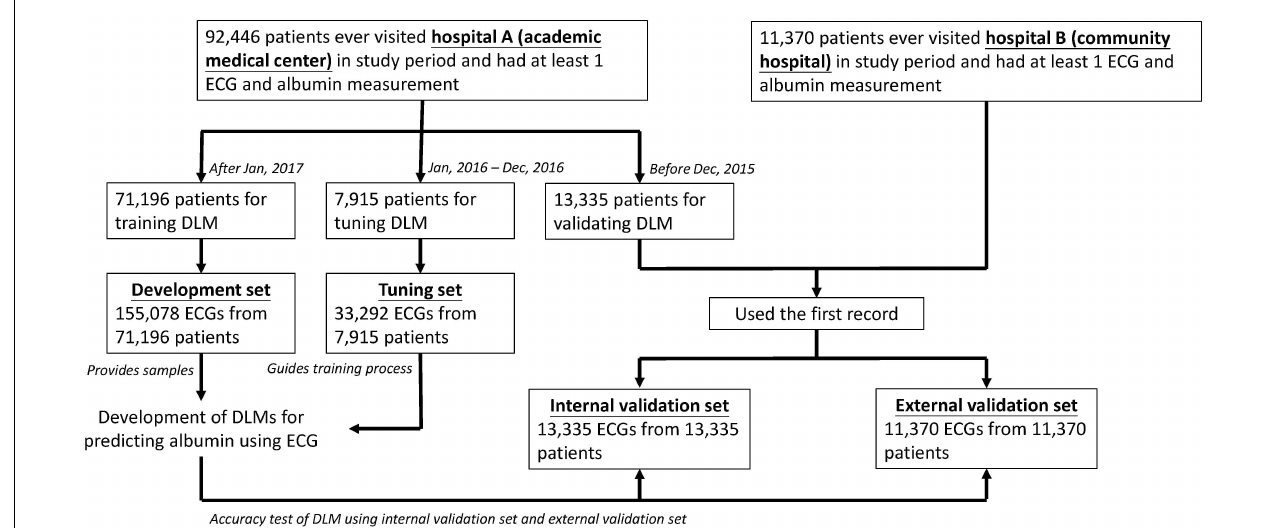
FIGURE 1 | Development, tuning, internal validation, and external validation set generation and ECG labeling of albumin. Schematic of the dataset creation and analysis strategy, which was devised to assure a robust and reliable dataset for training, validating, and testing of the network. Once a patient’s data were placed in one of the datasets, that individual’s data were used only in that set, avoiding “cross-contamination” among the training, validation, and test datasets. The details of the flow chart and how each of the datasets was used are described in “Materials and